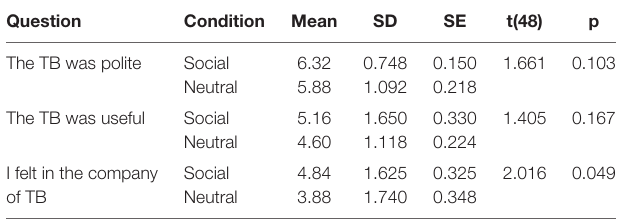
TaBle a5 | Social scale: social vs neutral results.